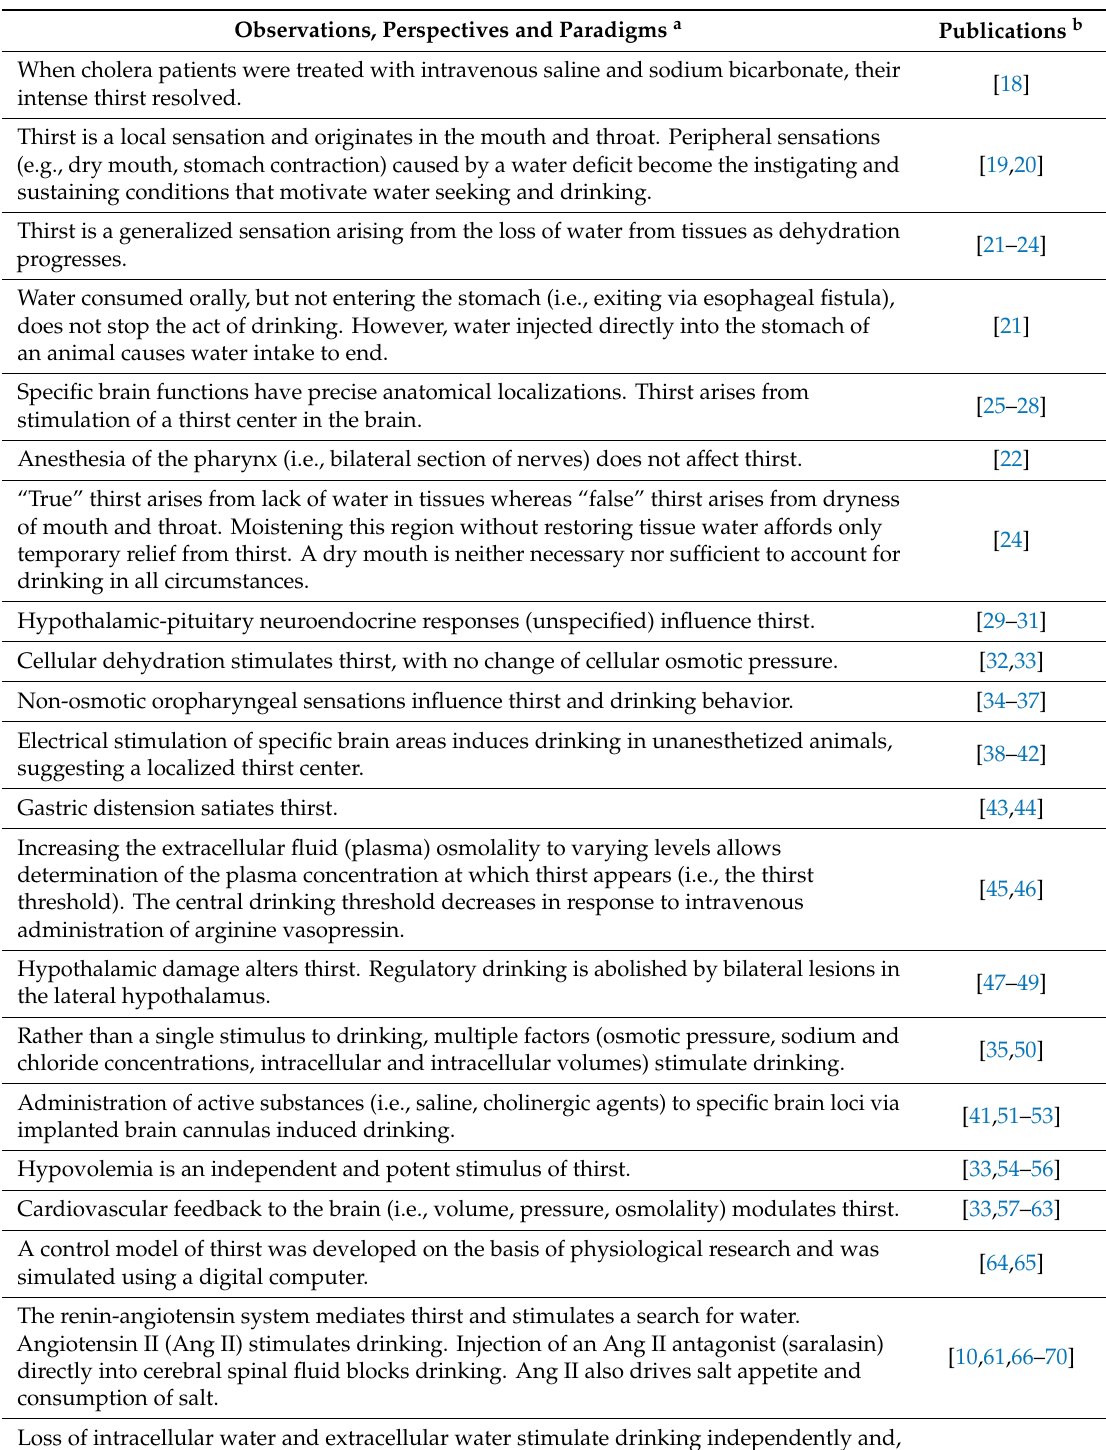
Table 1. Evolution of concepts and biological techniques regarding the nature and mechanisms of thirst and drinking